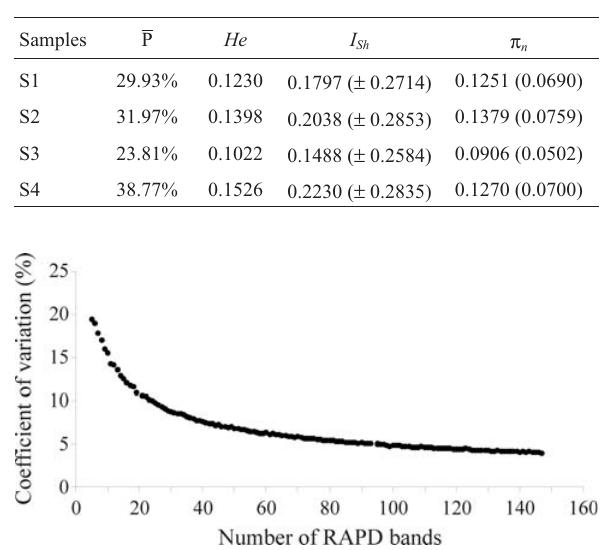
Table 2 - Proportion of polymorphic loci (P), average heterozygosity ( He ), Shannon’s diversity index ( I Sh ) and nucleotide diversity ( π n ) for the samples of H. ancistroides from sites S1, S2, S3 and S4 on the Cambé stream; ( ) = standard deviation.